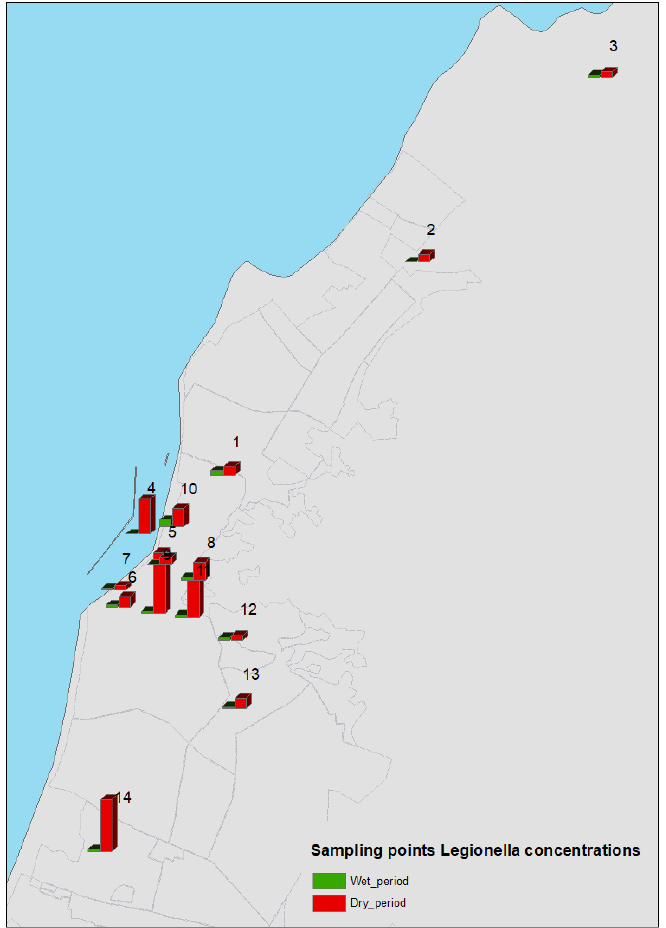
Figure 1. GIS map with sampling points and Legionella concentrations. The red columns correspond to the Legionella spp. concentrations in the dry period and the green columns to the Legionella spp. concentrations in the wet period.